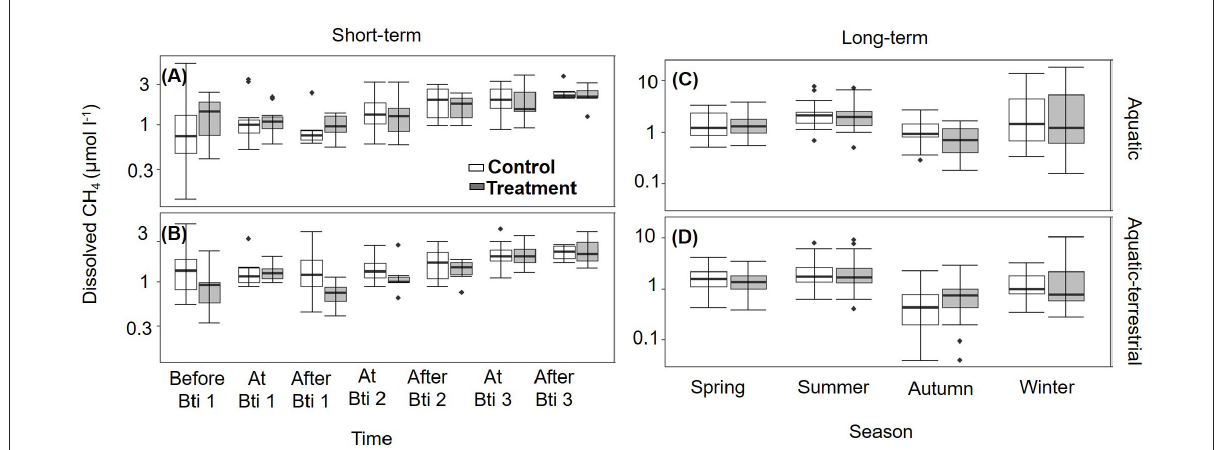
FIGURE2 Box plots for dissolved CH 4 concentration ( n = 6) measured in control (open boxes) and treated (filled boxes) FPMs. Data are presented for the short-term sampling during the Bti application period in the (A) aquatic and (B) aquatic-terrestrial compartments, and for the seasonal (long term) sampling in the (C) aquatic and (D) aquatic-terrestrial compartments. The lower and upper limits of the boxes show the 25th and 75th percentiles, respectively; the horizontal line inside the box is the median, and lower and upper whiskers show the 10th and 90th percentiles, respectively. Filled black circles are data falling outside the 10th and 90th percentiles. Note that y -axes are log-scaled.